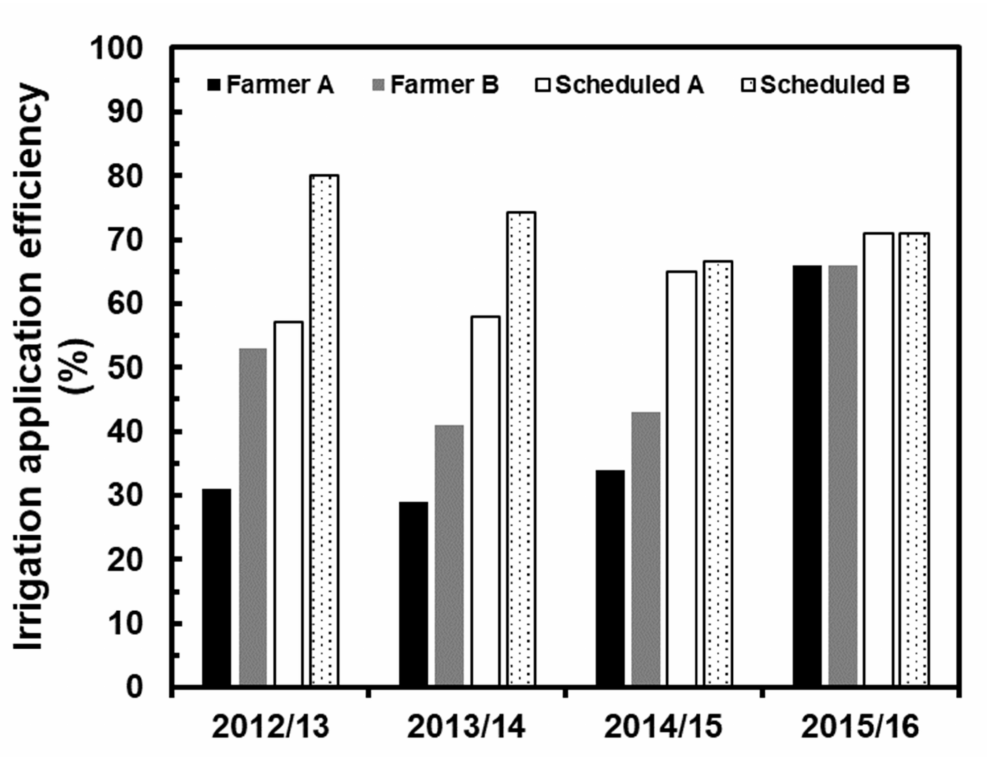
Figure 8. Irrigation application efficiency by Farmer A, Farmer B, and irrigation scheduled by IFAPA in both cases.